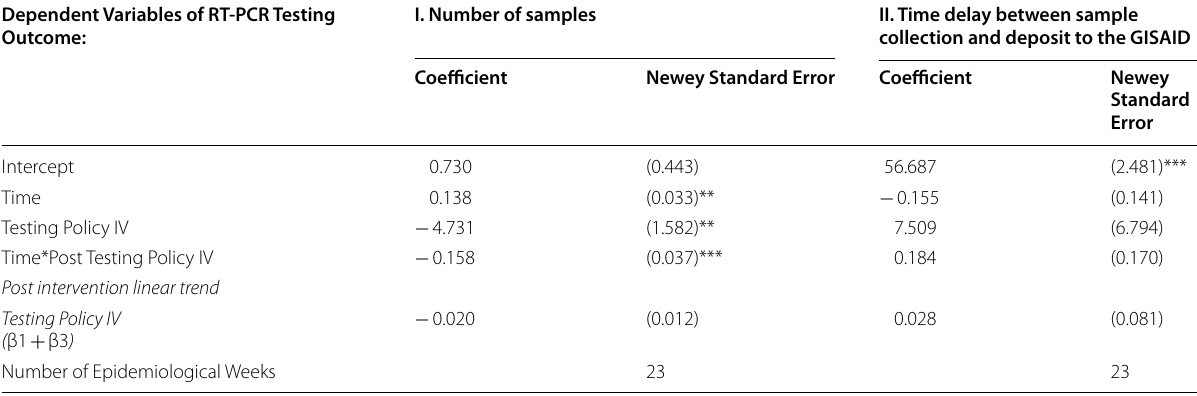
From December 27, 2020 to July 05, 2021 1 (aggregated data by week) For each dependent variable, the following segmented regression model was estimated: Y t *** p -value < 0.001, ** p -value < 0.05, * p -value < 0.1